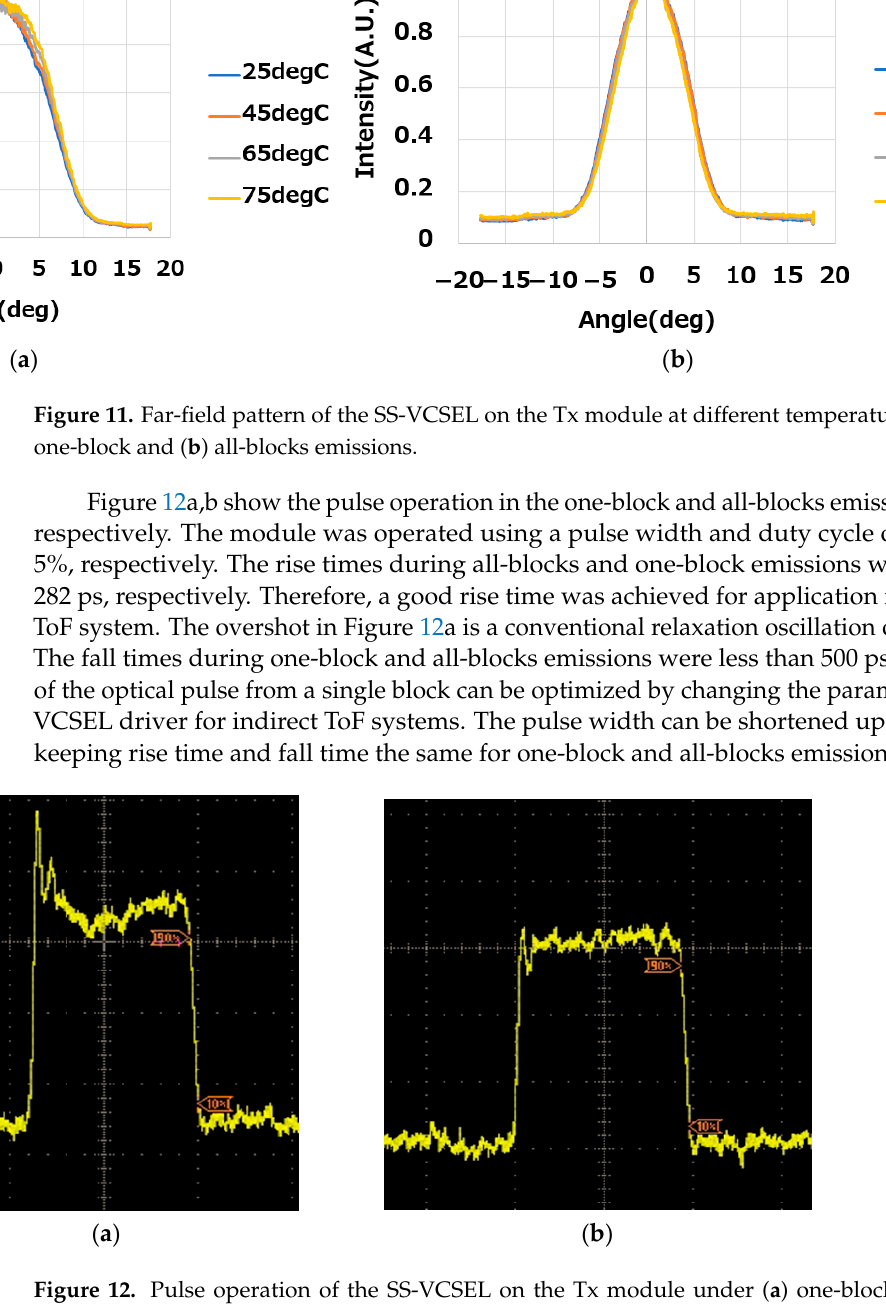
Figure 12. Pulse operation of the SS-VCSEL on the Tx module under ( a ) one-block and ( b ) all-blocks emissions.